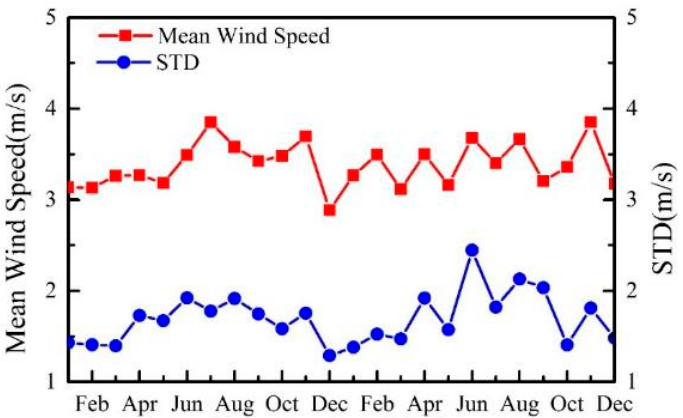
Figure 6. Monthly mean wind speed and its STD at Lau Fau Shan meteorological station in 2007 and 2008.